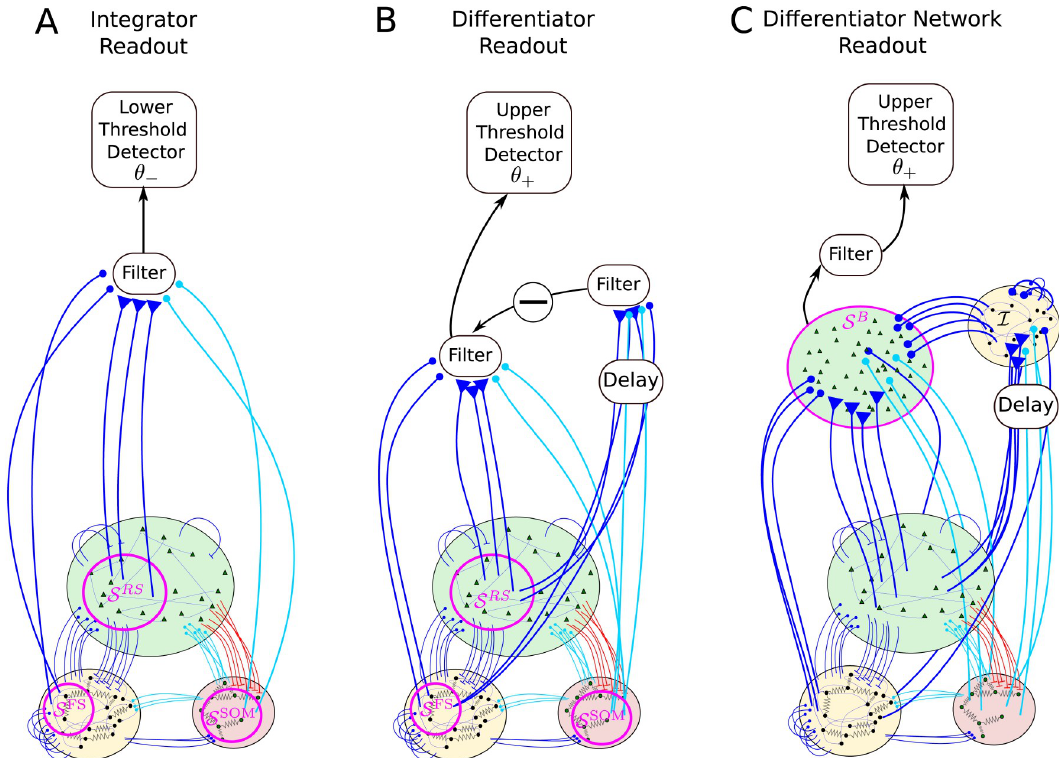
Fig 2. Readout models considered in this paper. One excitatory regular-spiking (RS) neuron from the barrel cortex network (BCN) is selected at random and stimulated. The BCN consists of three populations: RS neurons, inhibitory fast-spiking neurons (FS), and somatostatin-positive low-threshold spiking neurons (SOM-LTS), all modeled by leaky integrate-and-fire neurons. The BCN includes several biological details of the barrel cortex (see Fig 1 and Methods). Three readout schemes are considered. A : The integrator readout (IR) integrates the activity of a subset of the RS neurons within the BCN and reacts to deviations in the negative direction. B : The differentiator readout (DR) evaluates the difference between the IR activity at two time points separated by a delay. This filtered running difference at fixed lag is processed by the detector, which reacts when an upper threshold is reached. C : The differentiator network readout (DNR) approximates the operation of the DR with two populations of LIF neurons. The FS readout population ( I ) provides delayed recurrent inhibition to itself and feed-forward inhibition to the RS readout population ( S B ), the activity of which is fed to the upper threshold detector. All connections depicted in blue and light blue are dynamic and show short-term depression